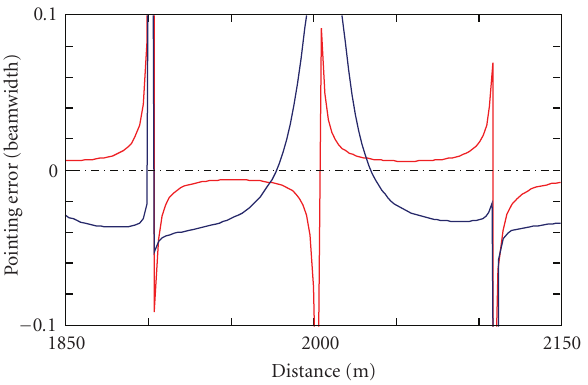
Figure 15: Pointing error, in elevation (red) and azimuth (blue) for an enhanced crossfeed monopulse with a 10 ◦ inclination around antenna boresight direction (roll or pitch). A 2 ◦ phase error on the elevation secondary channel is also